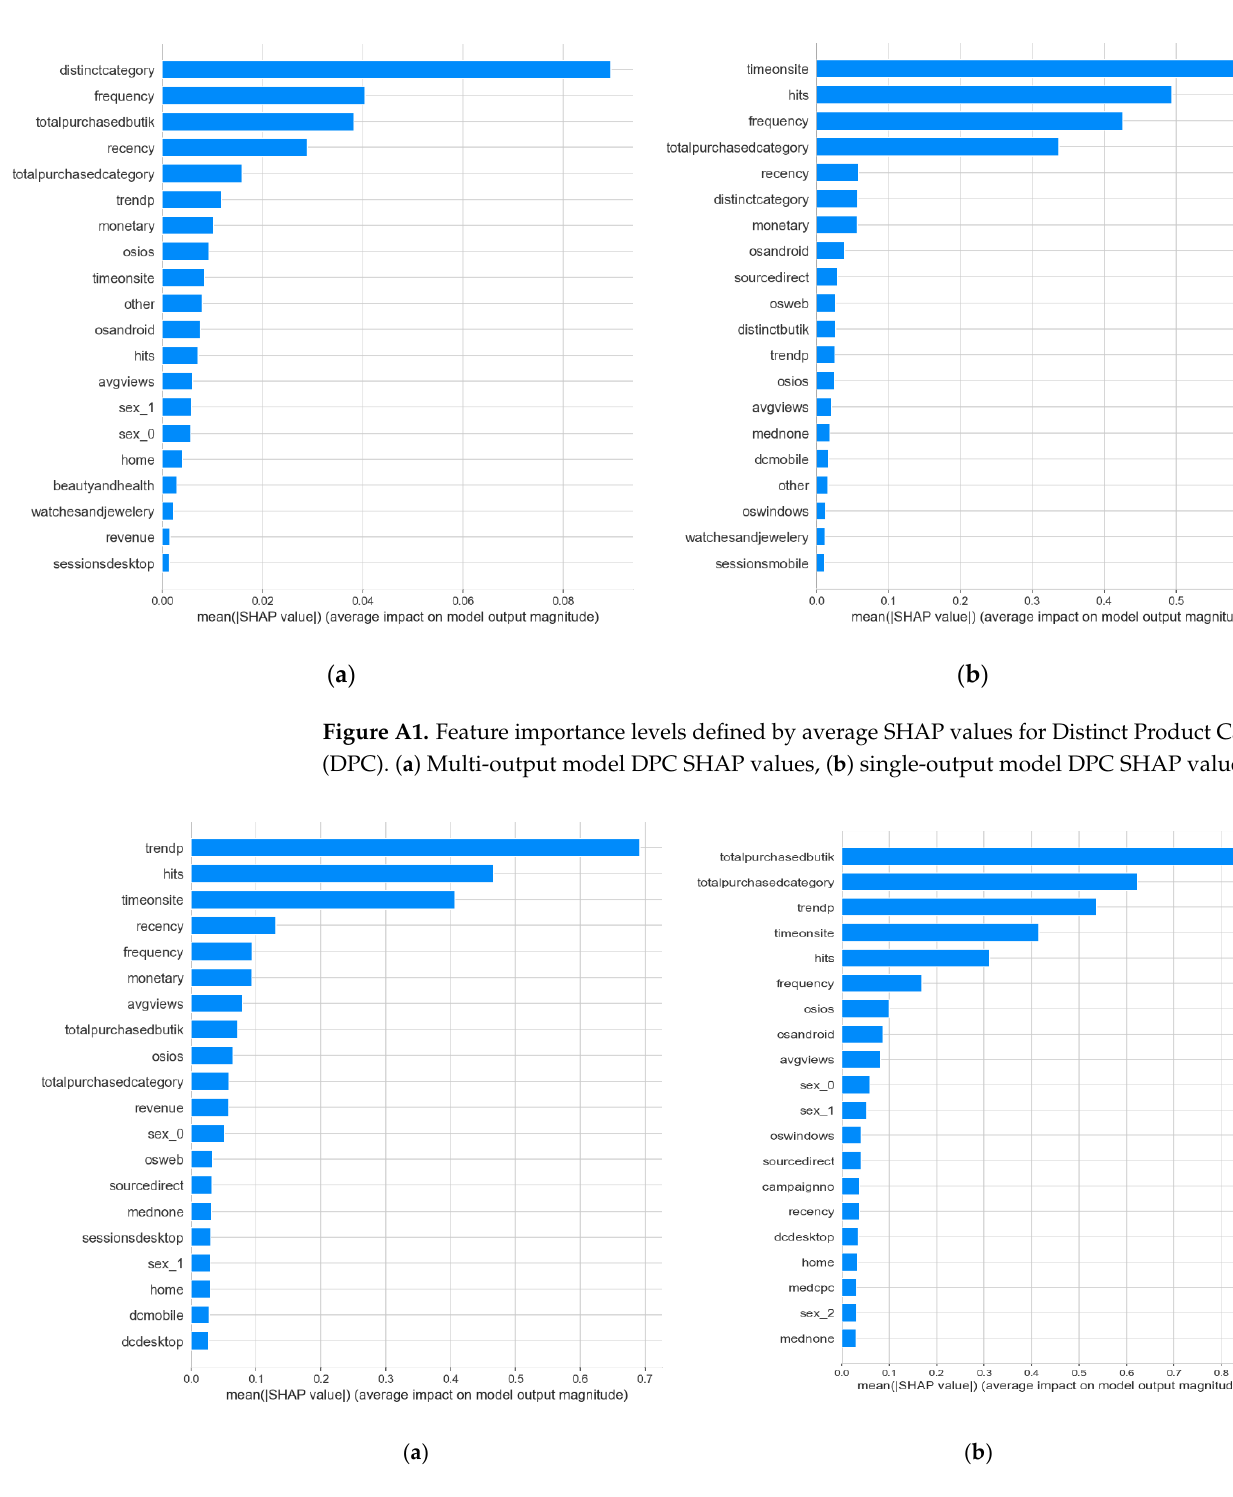
Figure A2. Feature importance levels defined by average SHAP values trend in amount spent (TAS)